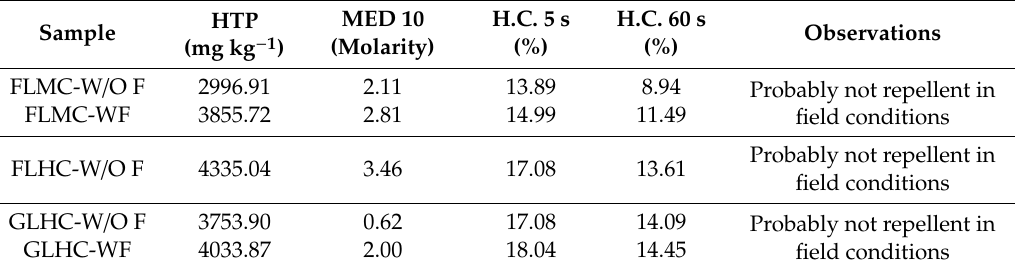
Table 1. Critical humidity in Fluvisol and